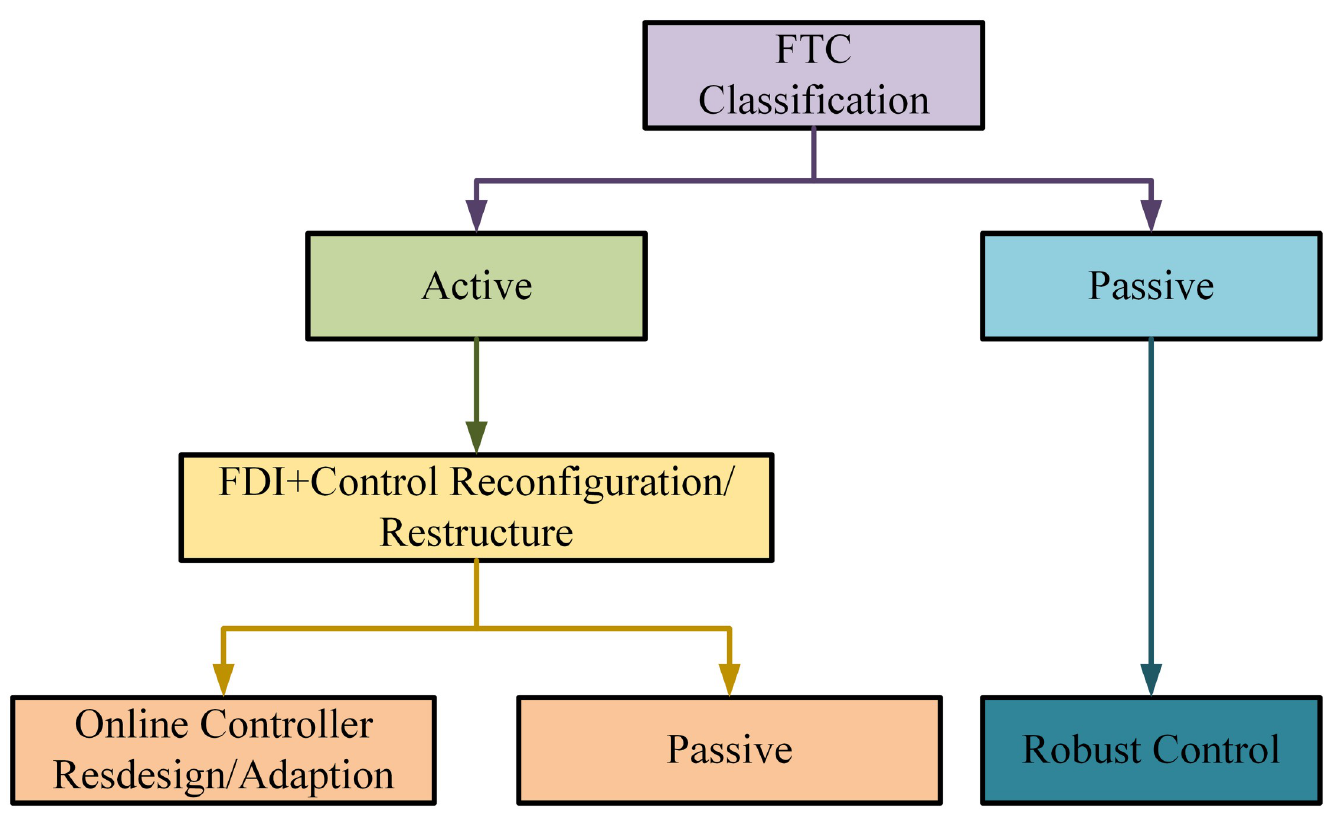
Fig 2. FTC classification.